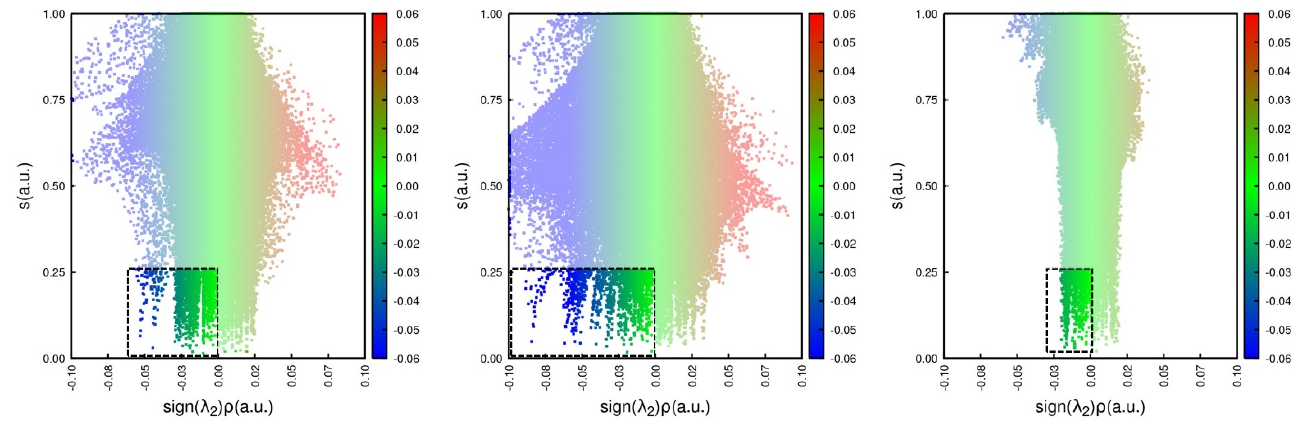
Figure 9. Scatter plot of non-covalent interactions, by color, as a function of the second Hessian matrix and electron density. Left: DS1 site. In the center: DS3 site. Right: FA6 site.